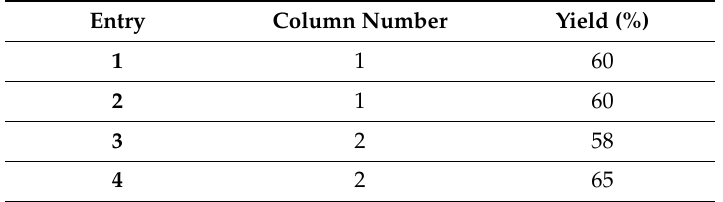
Table 3. Recycled [DMPIm][NTf 2 ] product yields.